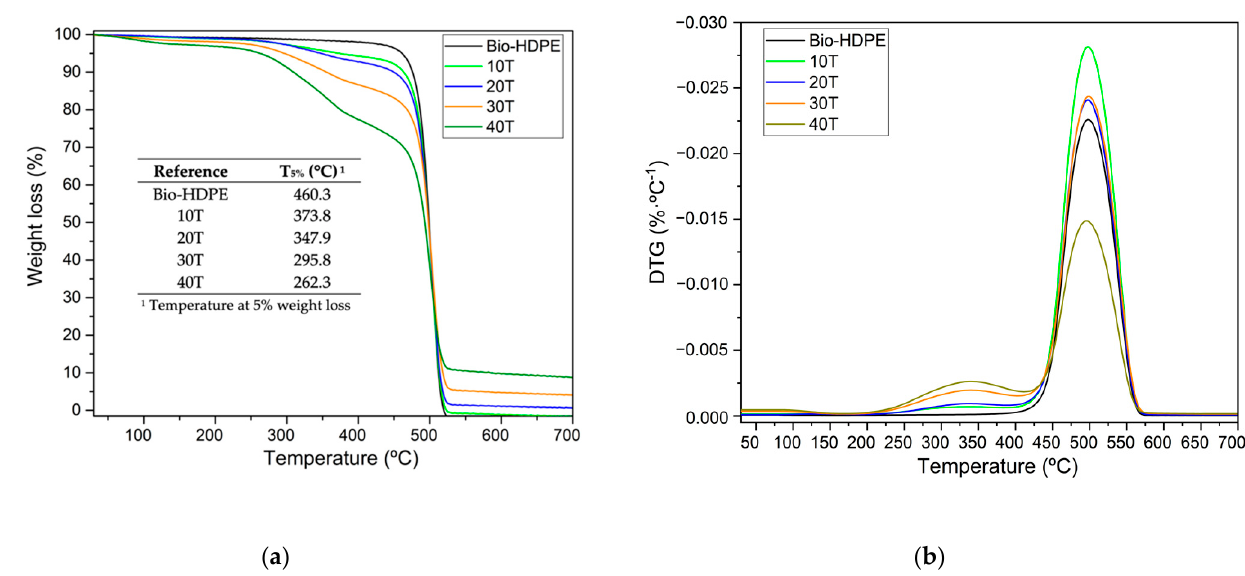
Figure 10. Thermal parameters of degradation of bio-based high-density polyethylene (Bio-HDPE) with different weight percentage of treated chia seed flour with APS. ( a ) Weight loss; ( b ) Derivative thermogravimetry. T 5% is temperature at 5% weight loss; T max1 and T max2 is maximum degradation temperature for first and second stage.